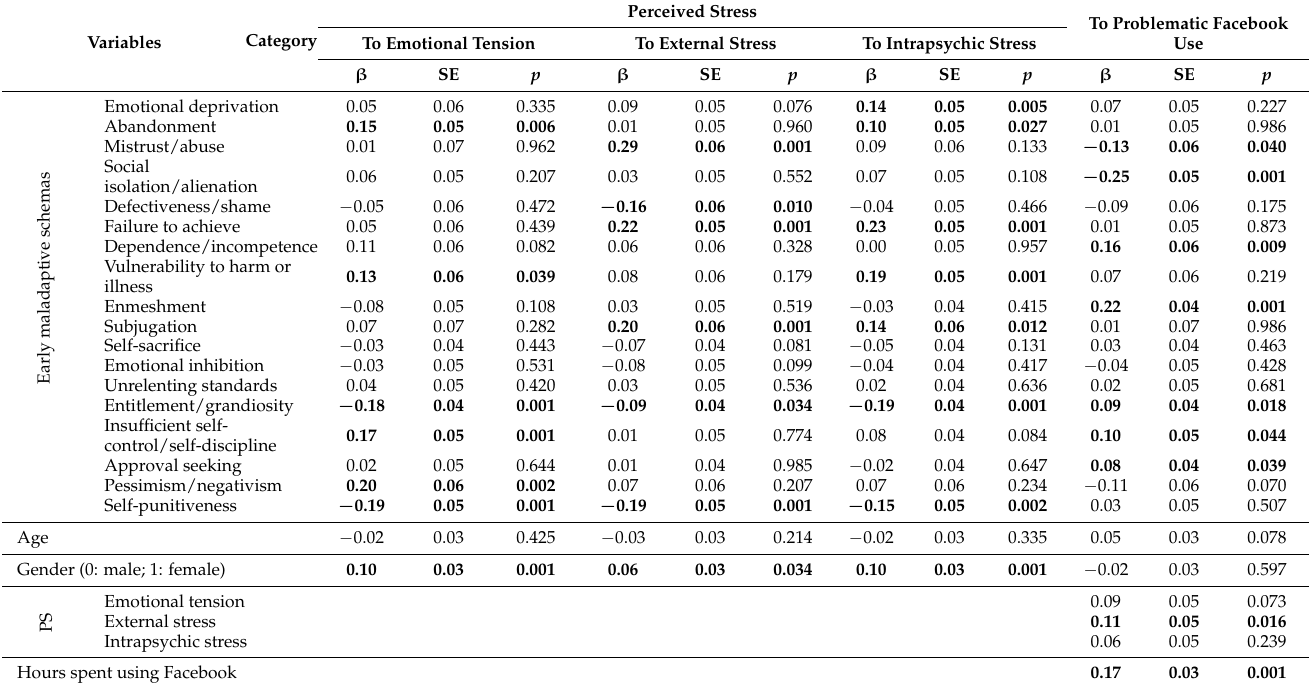
Table 4. Standardized path coefficients for perceived stress dimensions and problematic Facebook use among Facebook users (N =